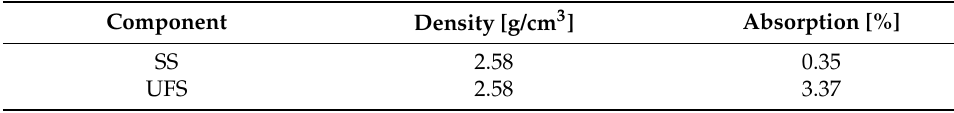
Table 2. Physical properties of the aggregates used.